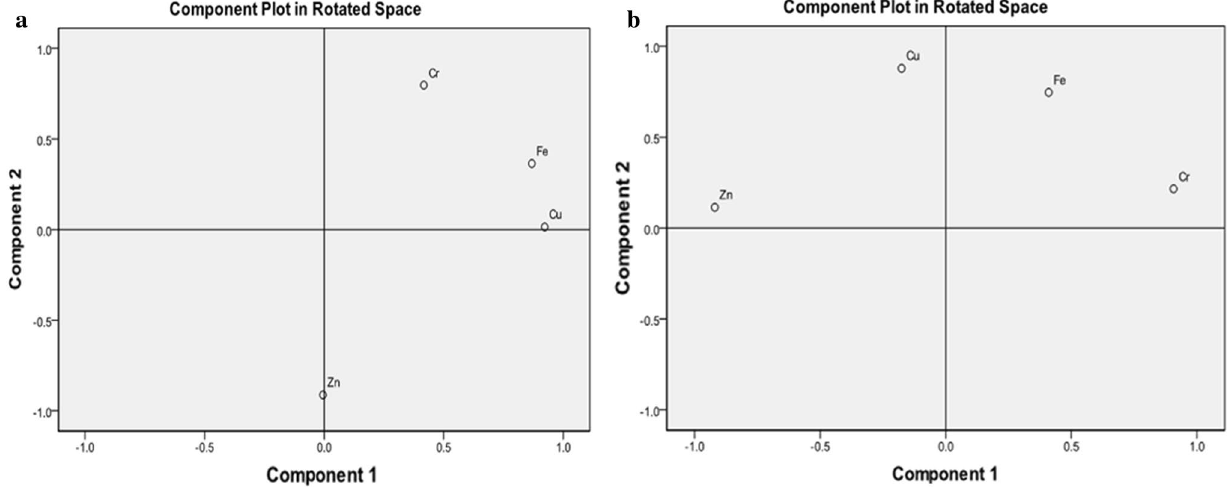
Fig. 5 PCA loadings and score plot of heavy metal during: a pre-monsoon months; b post-monsoon